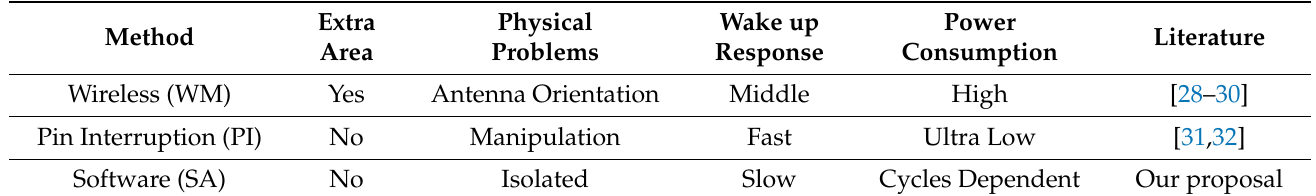
Table 1. Advantages and weaknesses of the trigger mechanisms switching to supervisor mode.